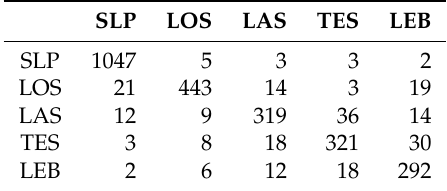
Table 4. Confusion matrixes for the results of pad sensors.